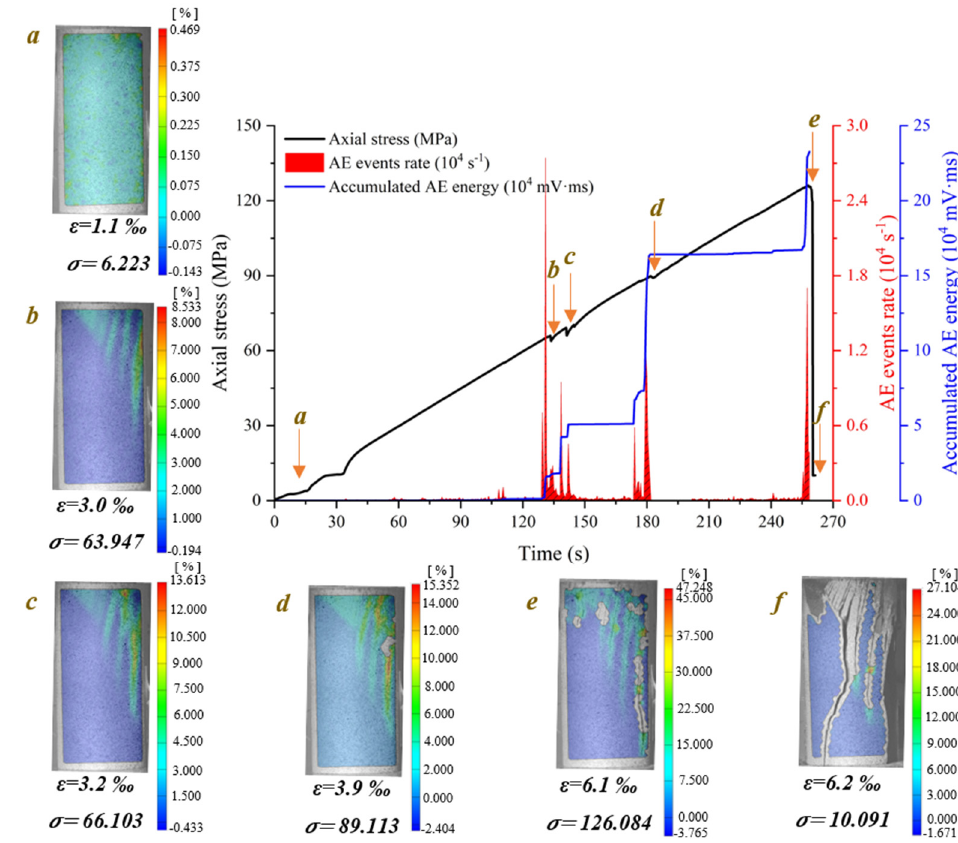
Figure 9. Crack evolution process of dry phyllite with 90° foliation angle (S-D-90°).